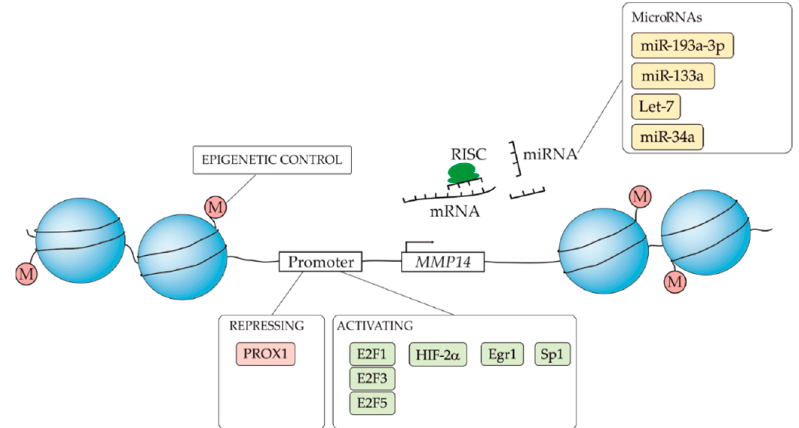
Figure 2. MMP14 is regulated at the transcriptional level by multiple activators (highlighted in green) and a repressor (in red). DNA methylation (M) in the promoter region also regulates the transcription of the MMP14 gene. At the first post-transcriptional level, various microRNAs (in yellow), including several microRNAs with reported activities in various types of sarcoma, have been shown to target and thus reduce the translation of MMP14 mRNA.